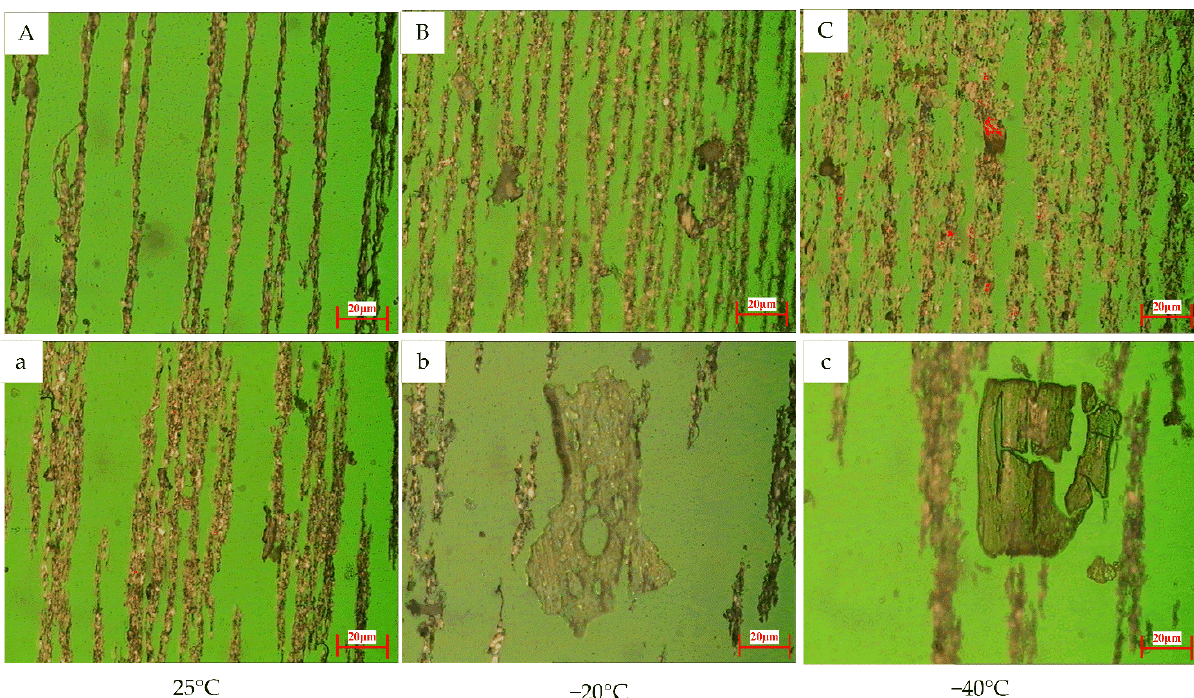
Figure 10. Morphology of abrasive grains of the friction pairs of the two materials at different temperatures. ( A – C ) are morphology of abrasive grains of the friction pair of LC2-1 with QT350-22L when the test temperatures are 25 ◦ C, − 20 ◦ C and − 40 ◦ C, respectively; ( a – c ) are morphology of abrasive grains of the friction pair of QT500-7 with QT350-22L when the test temperatures are 25 °C, −20 °C and −40 °C, respectively.